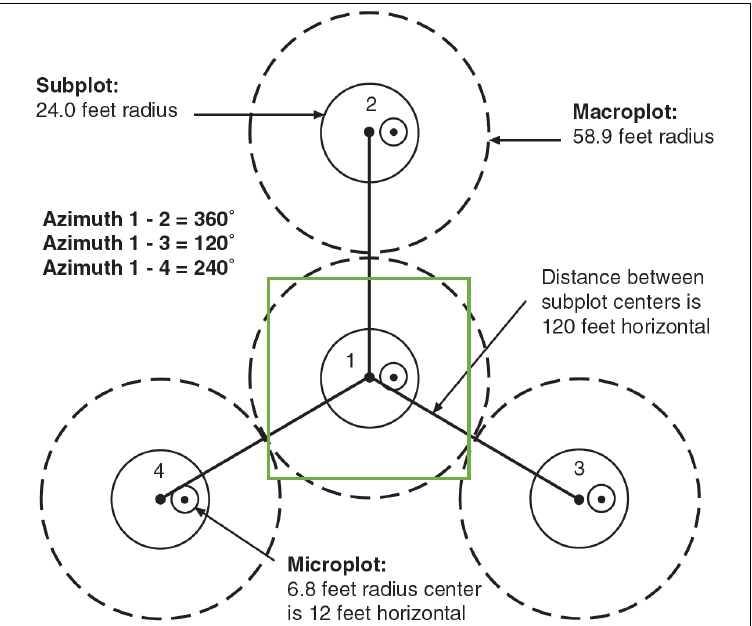
Figure 2. TheALSplot(greenoutline)inreferencetotheFIAplot(blackmarkings).